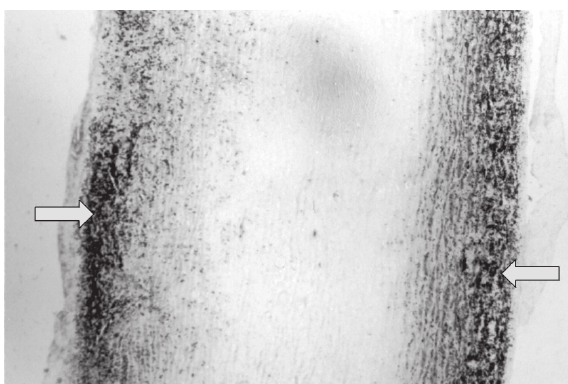
Fig. 8 - Fotomicrografia mostrando corte longitudinal de parede aórtica tratada com glutaraldeído, apresentando calcificação difusa e acentuada após 30 dias do implante. GDA subgrupo 30 dias (von Kossa 100x).